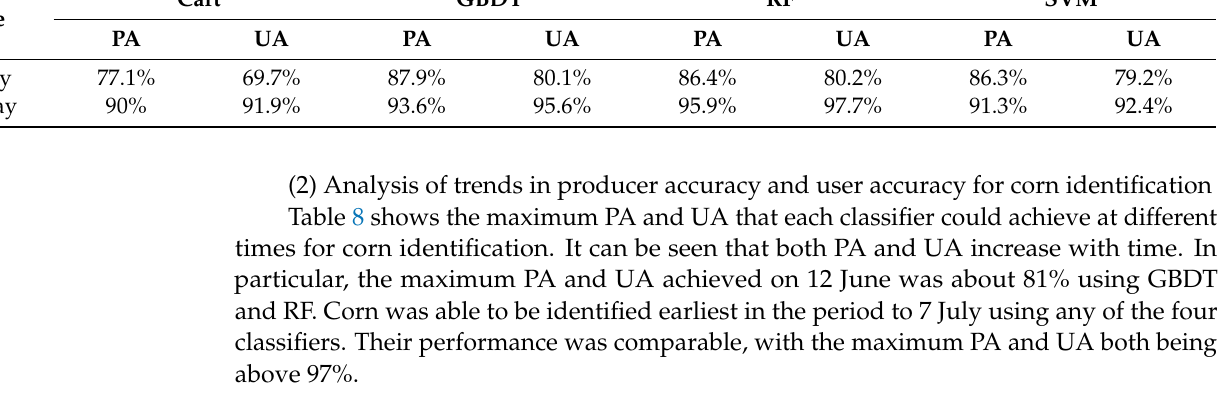
Table 8. Maximum PA and UA of corn in 2020 different periods.